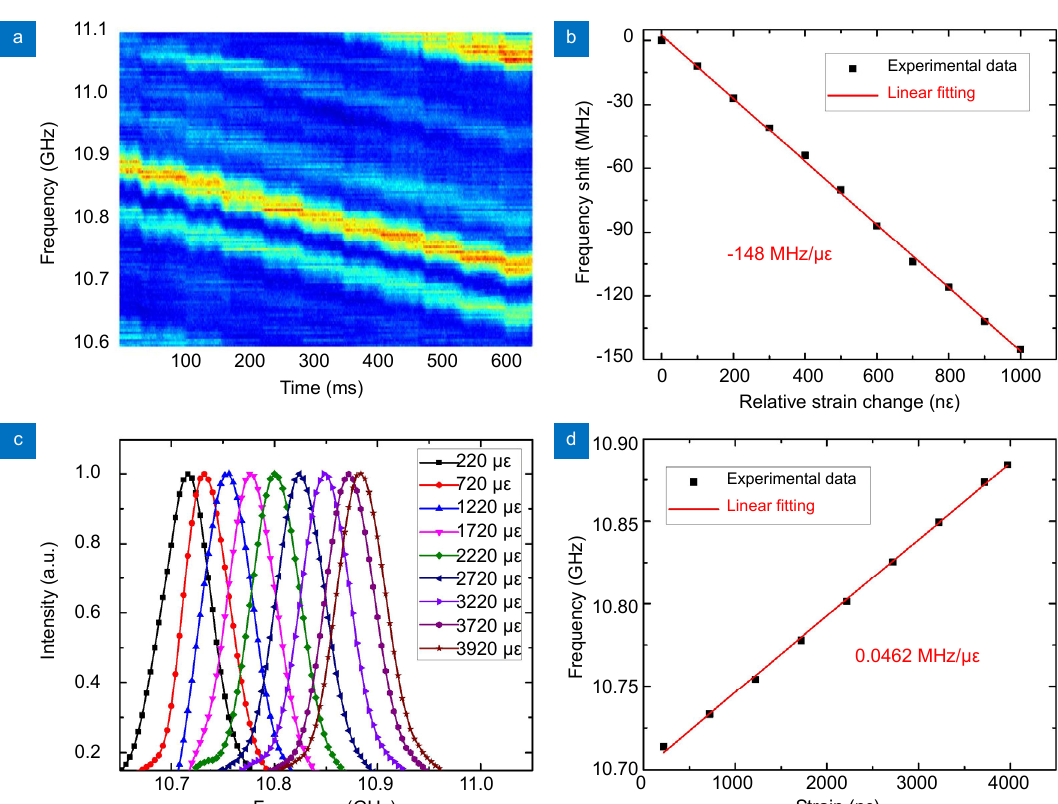
Fig. 6 | ( a ) The measured Rayleigh spectra recording a 1000 n ε relative strain change with a step of 100 n ε . ( b ) The frequency shift in different relative strain change and its linear fitting result. ( c ) The measured BGSs at different strains from 220 με to 3970 με . ( d ) The BFS in different strains and its linear fitting